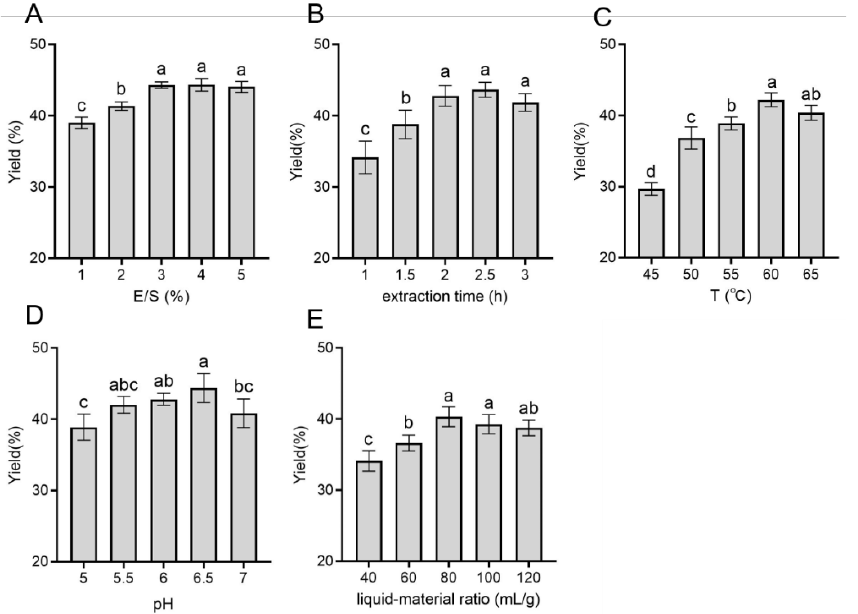
Figure 1. DOPs extraction yield at different ( A ) E/S, ( B ) extraction times, ( C ) extraction temperatures, ( D ) pH, and ( E ) liquid–material ratios. Extraction yield results were reported as means ± SD, and the bars with various letters (a–d) showed statistically significant differences ( p < 0.05).